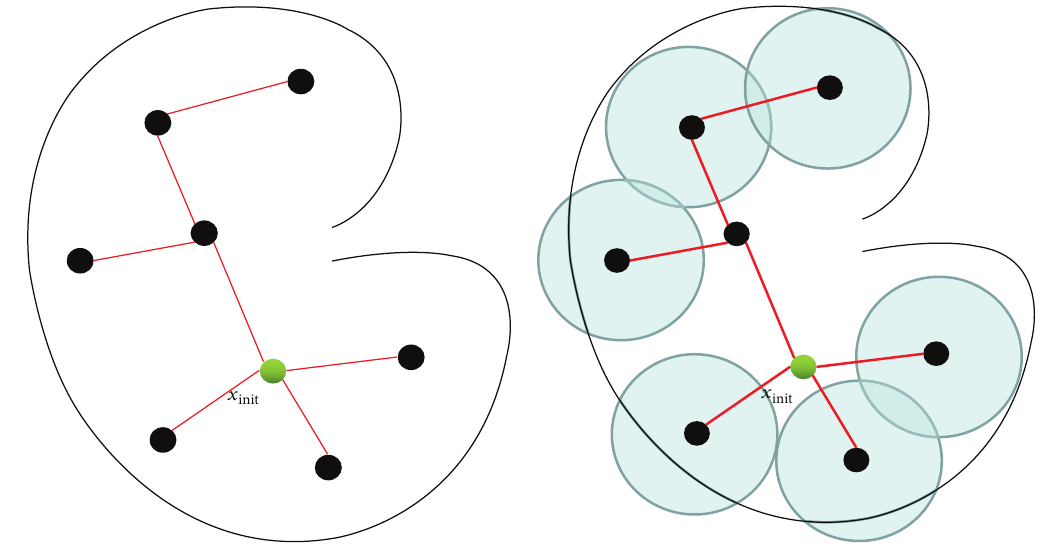
Figure 8: DDRRT compares with general RRT.